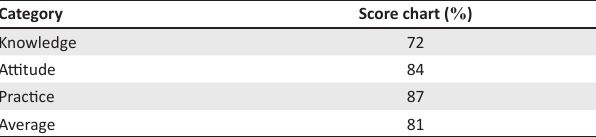
TABLE 5: Knowledge, attitude and practice scores chart. Category